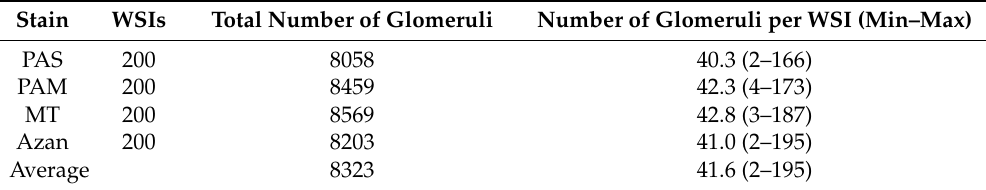
Table 2. Summary of